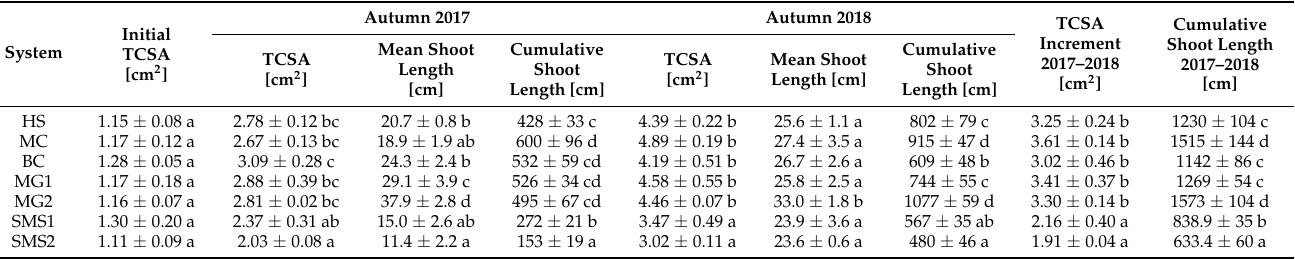
Table 5. TCSA and its growth and the shoot lengths of tested apple trees depended on the floor management system used during the